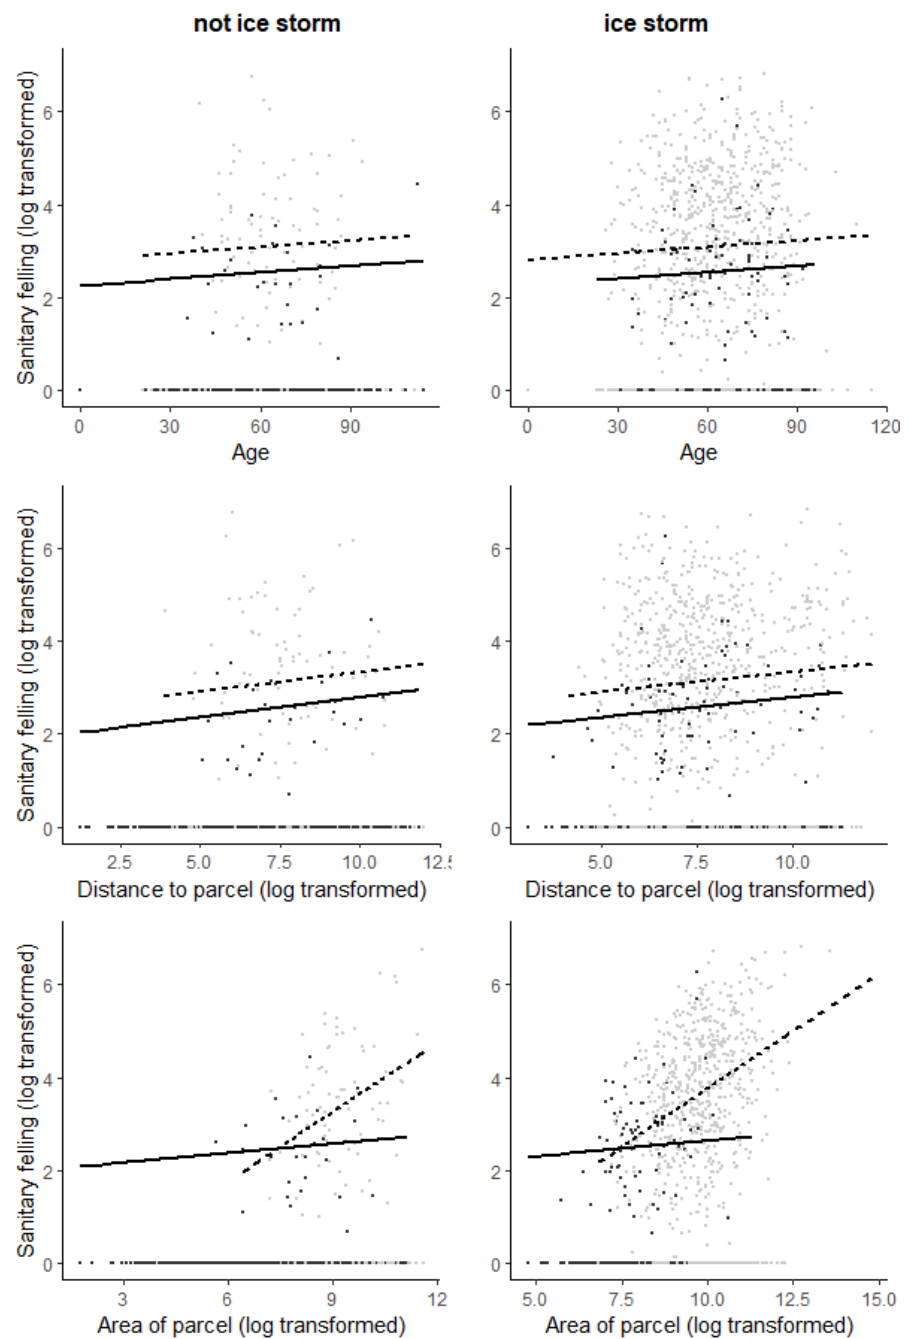
Figure 1. Association of the different characteristics of the privately owned parcels with the presence of the ice storm and the amount of spruce with the amount of sanitary felling (m 3 ). The grey dots and the black dashed line show a high amount of spruce and the black solid line and black dots show a low amount of spruce. Prediction lines are only shown for the spatial error model in which sanitary felling > 0.